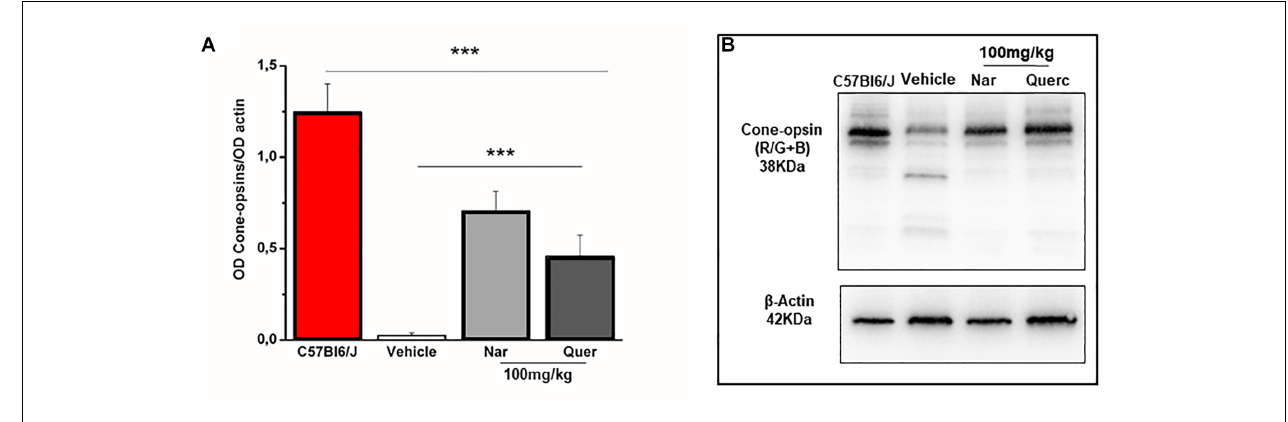
FIGURE 2 | Naringenin and quercetin reduce the loss of cone after 27 days of treatment in rd10 mice. (A) Relative intensity of total cone-opsins (R/G + B) immunoreactive band quantified by densitometry scanning. Asterisks indicate significance ( ∗∗∗ p < 0.001) by two-way ANOVA followed by pair-wise t -test comparison with Bonferroni’s correction ( n = 4 for wt C57Bl/6J mice and n = 6 for each treatment group). (B) Scanning image to representative